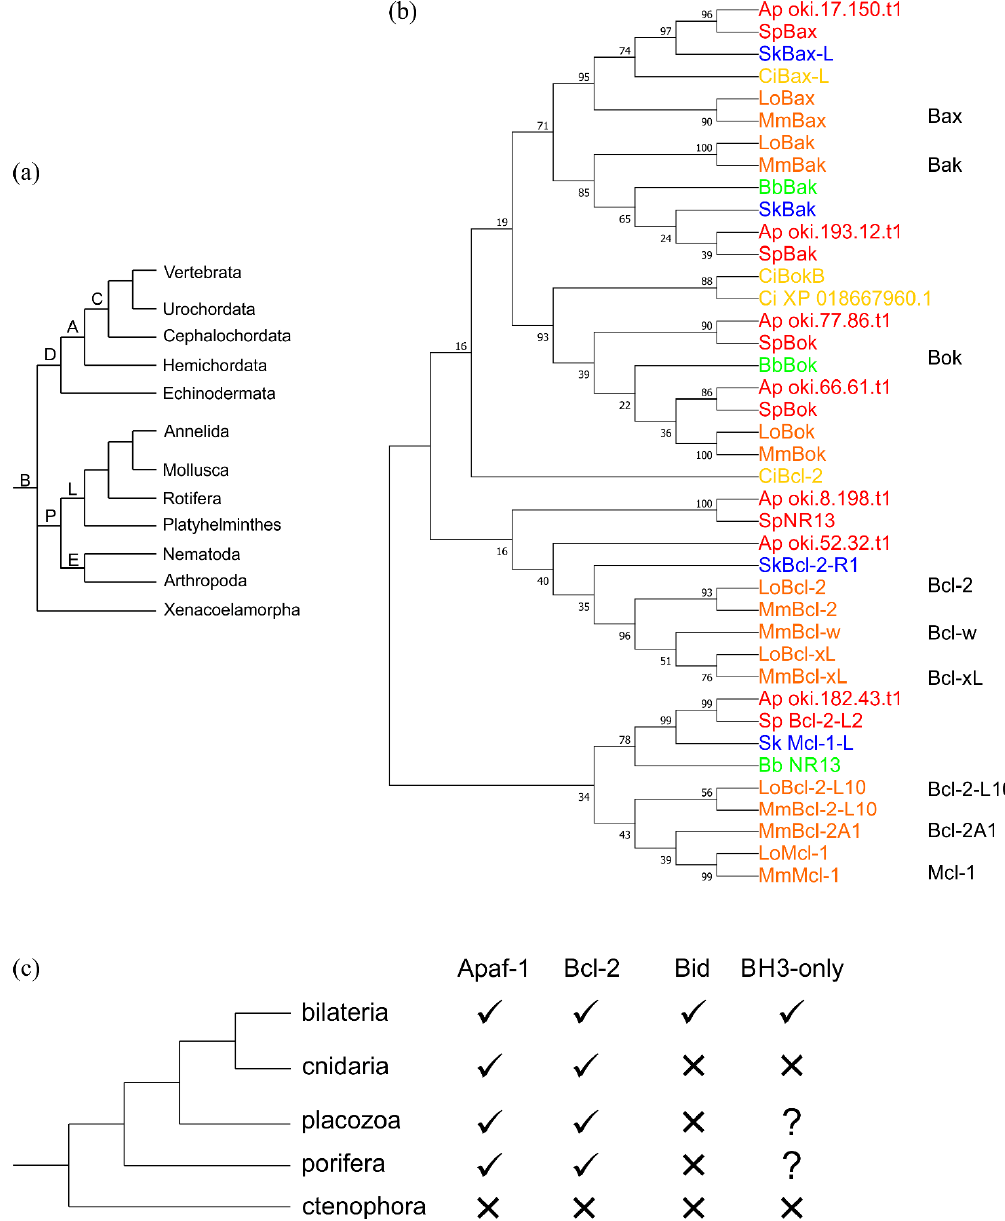
Figure 4. Simplified consensus phylogeny of bilaterians. ( a ) Current bilaterian phylogeny. The branches are indicated: B, Bilaterian; D, Deuterostomia; A, Ambulacraria; C, Chordata; P, Protostomia; L, Lophochotrozoa; E, Ecdysozoa. ( b ) Molecular Phylogenetic analysis by maximum likelihood method of selected metazoans. The mouse Bcl-2 proteins are indicated on the right and the colours signify the phylum; yellow, urochordata C. intestinalis (Ci); echinodermata, red, A. planci , (Ap); S. purpuratus (Sp); blue hemichordata, S. kowalevskii (Sk); green Cephalochordata, Bp, B. belcheri ; orange Vertebrata, M. musculus , L. oculatus . The evolutionary history was inferred using MEGA7 [34] by the maximum likelihood method and performed on 40 protein sequences having 131 positions in the final dataset. Sequences were aligned in MEGA7 using Muscle and the evolutionary history was inferred by using the maximum likelihood method calculating 1000 replicates and the tree with the highest log likelihood ( − 10,217.45) is shown. The percentage of trees in which the associated taxa clustered together is shown next to the branches. ( c ) A simplified phylogenetic tree for Bilateria and the basal metazoans indicating the presence or absence of key apoptosis genes. A (cid:88) indicates genes(s) are present in the phylum while an × indicates the absence of